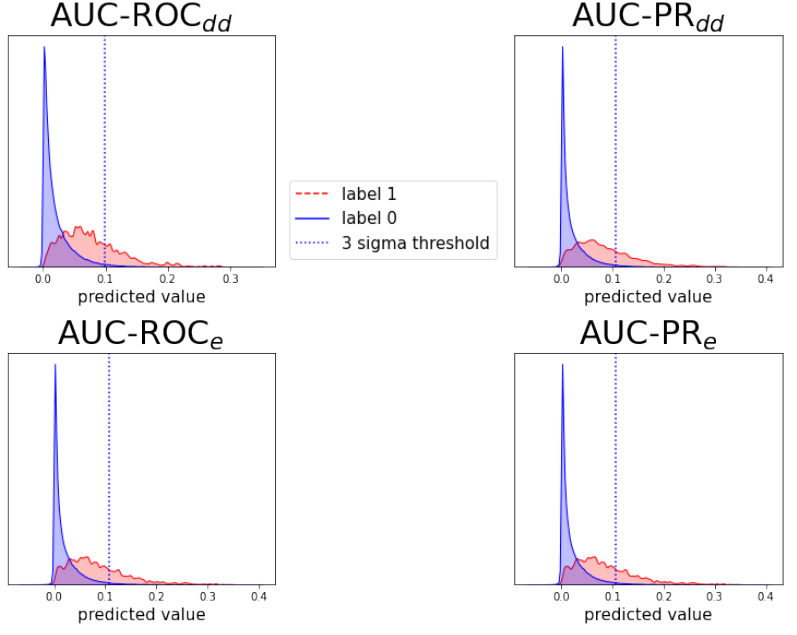
Figure A9. Analogous to Figure A6, for prediction task (cid:98) d (cid:98) de